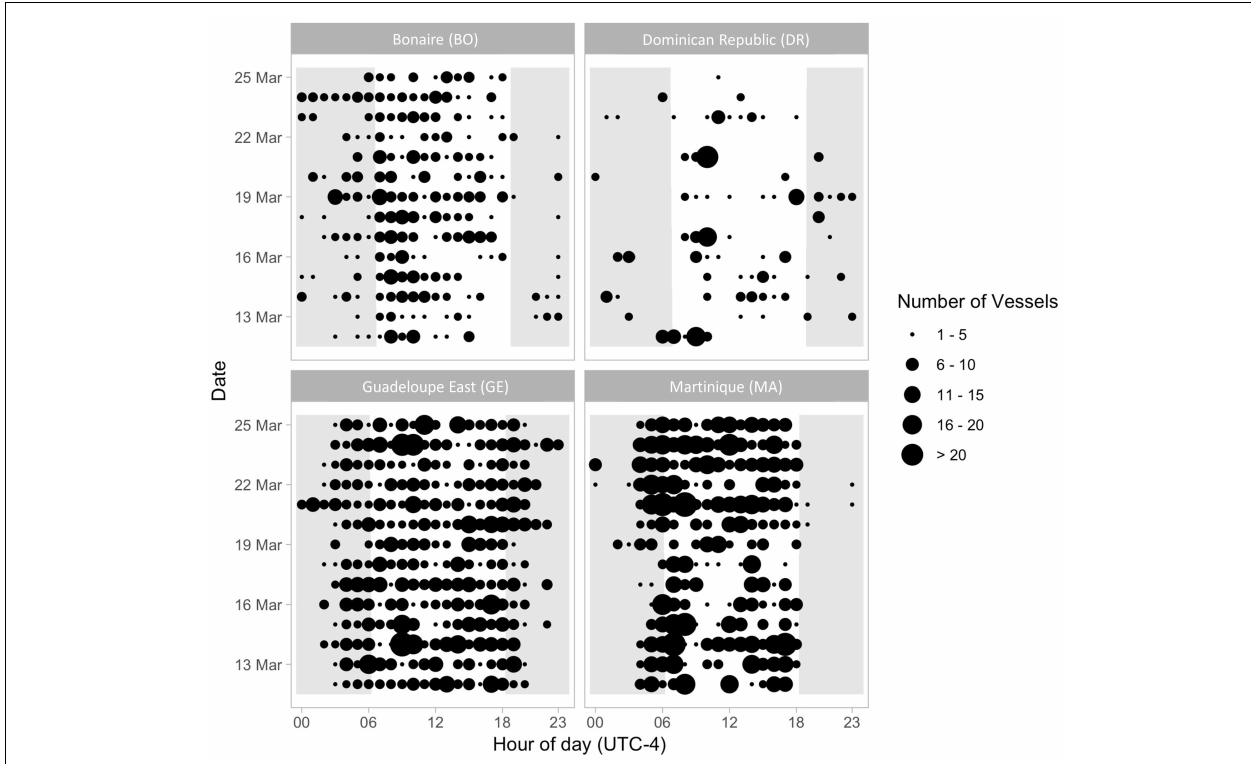
FIGURE 5 | Diel patterns in the hourly number of vessel passages at each recording site from 12 March 2017 to 25 March 2017. Dot size indicates the number of vessel passages acoustically detected for per hour on each day. Light gray shading indicates hours before sunrise and after